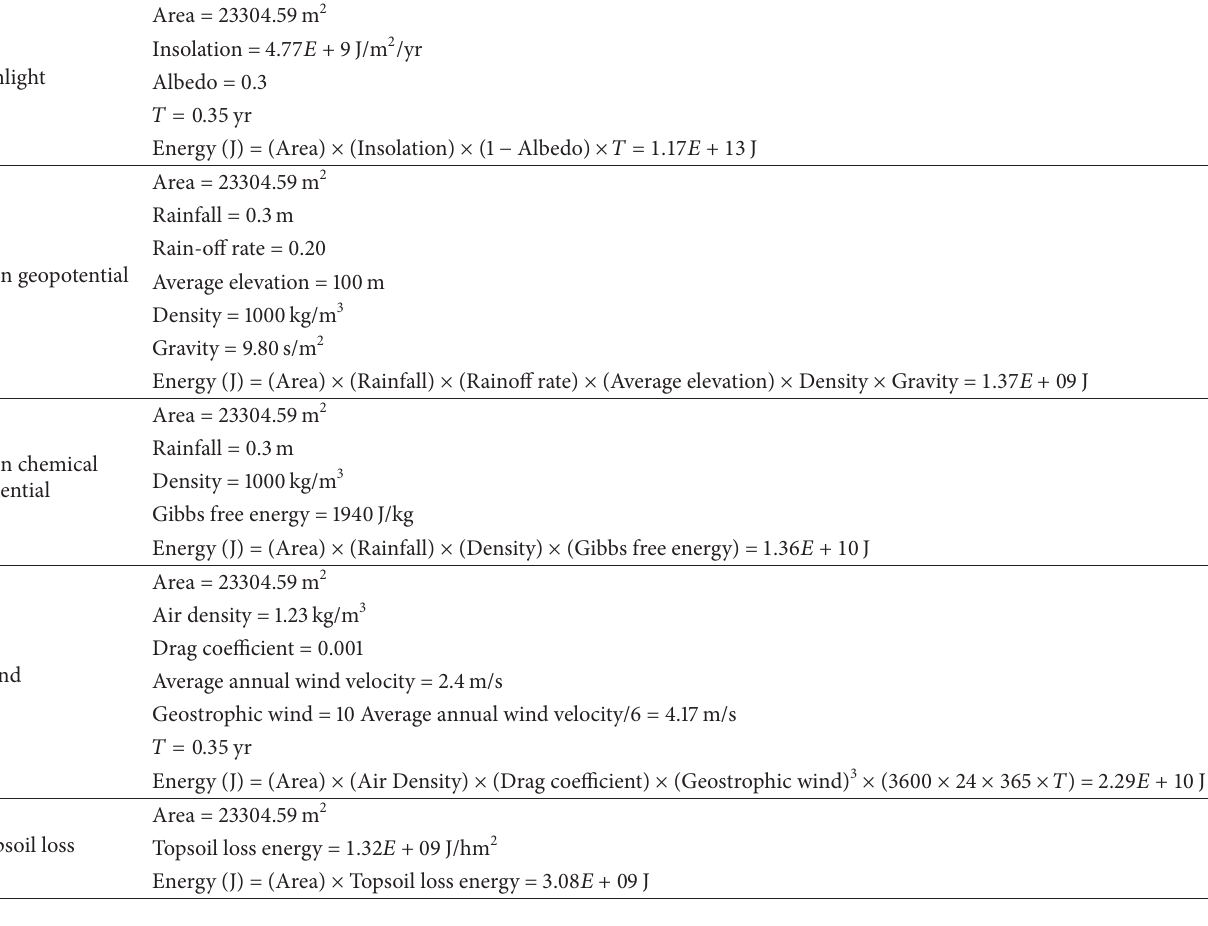
Table 2: Calculation of the available energy of each item for soybean-based biodiesel.